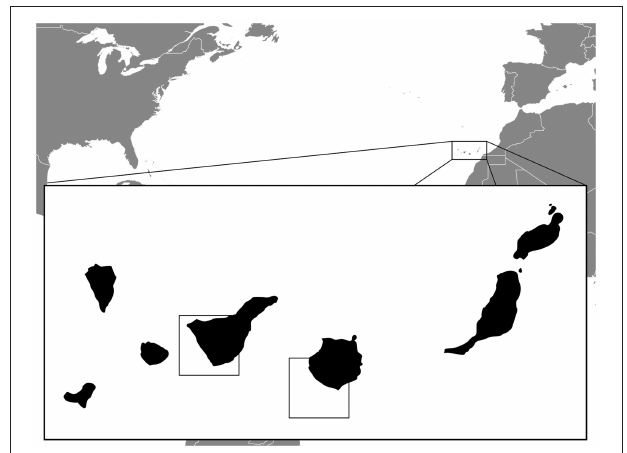
FIGURE 1 | Canary Islands and study sites off south Tenerife and Gran Canaria